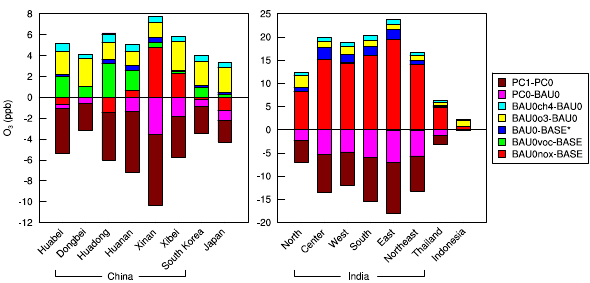
Figure 14. Differences in simulated annual mean surface ozone concentrations among cases which are averaged over regions in China and India as well as Japan, South Korea, Thailand, and In-